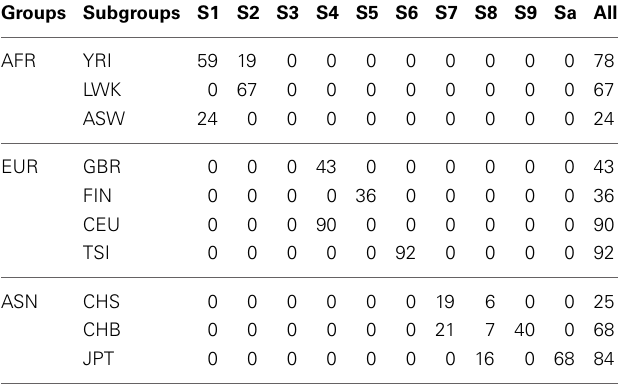
Table 6 | The numbers of subjects assigned to each of the 10 clusters based on the top 10 PCs using the existing SSSC algorithm ( α = 0 , β = 1 ) with SSR =